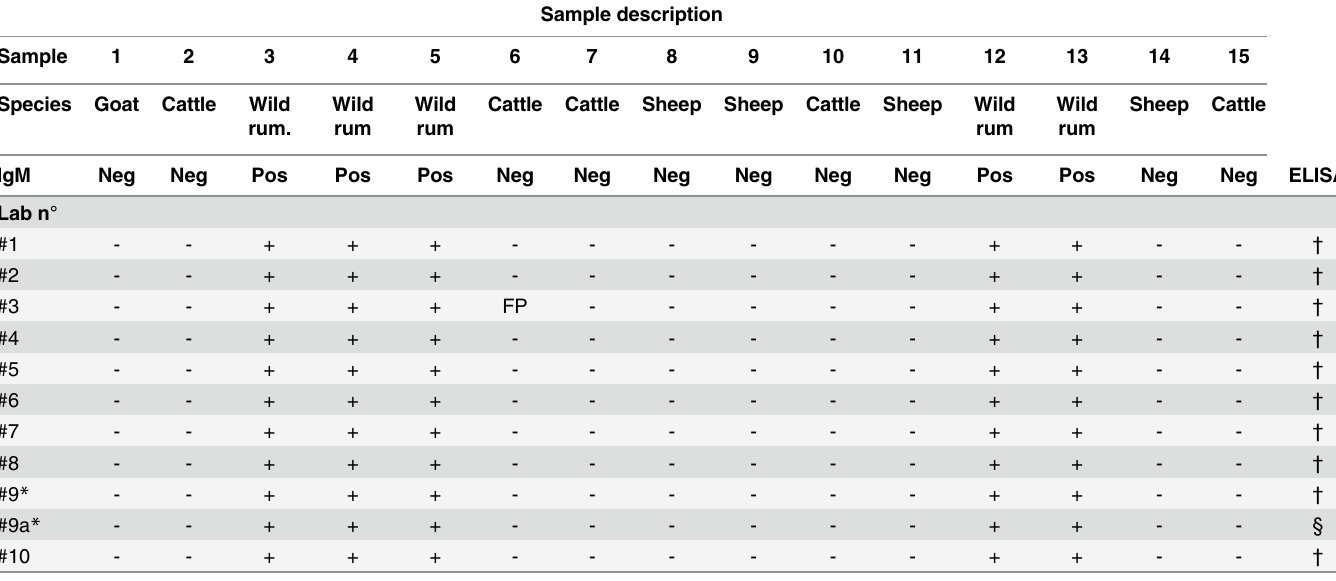
Wild rum: wild ruminants ( Antidorcasmarsupialis ). Pos: RVF seropositive status; Neg: RVF seronegative status. + / — : samples identi fi ed as positive or negative by the participants. FP: false positive